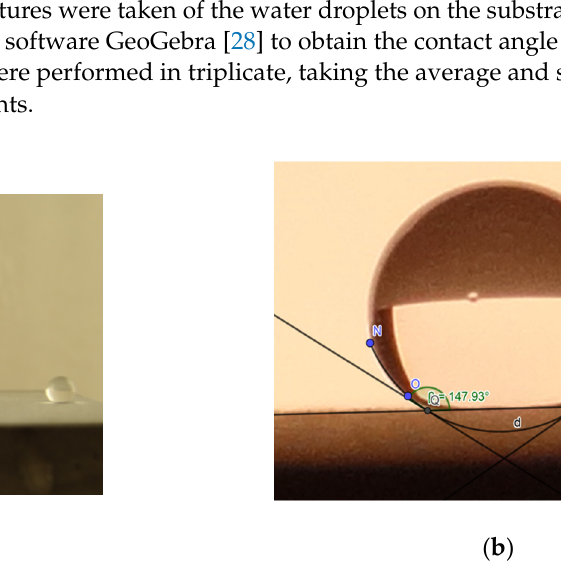
Figure 3. ( a ) Water drops rolling off ( b ) Water contact angle measurement.